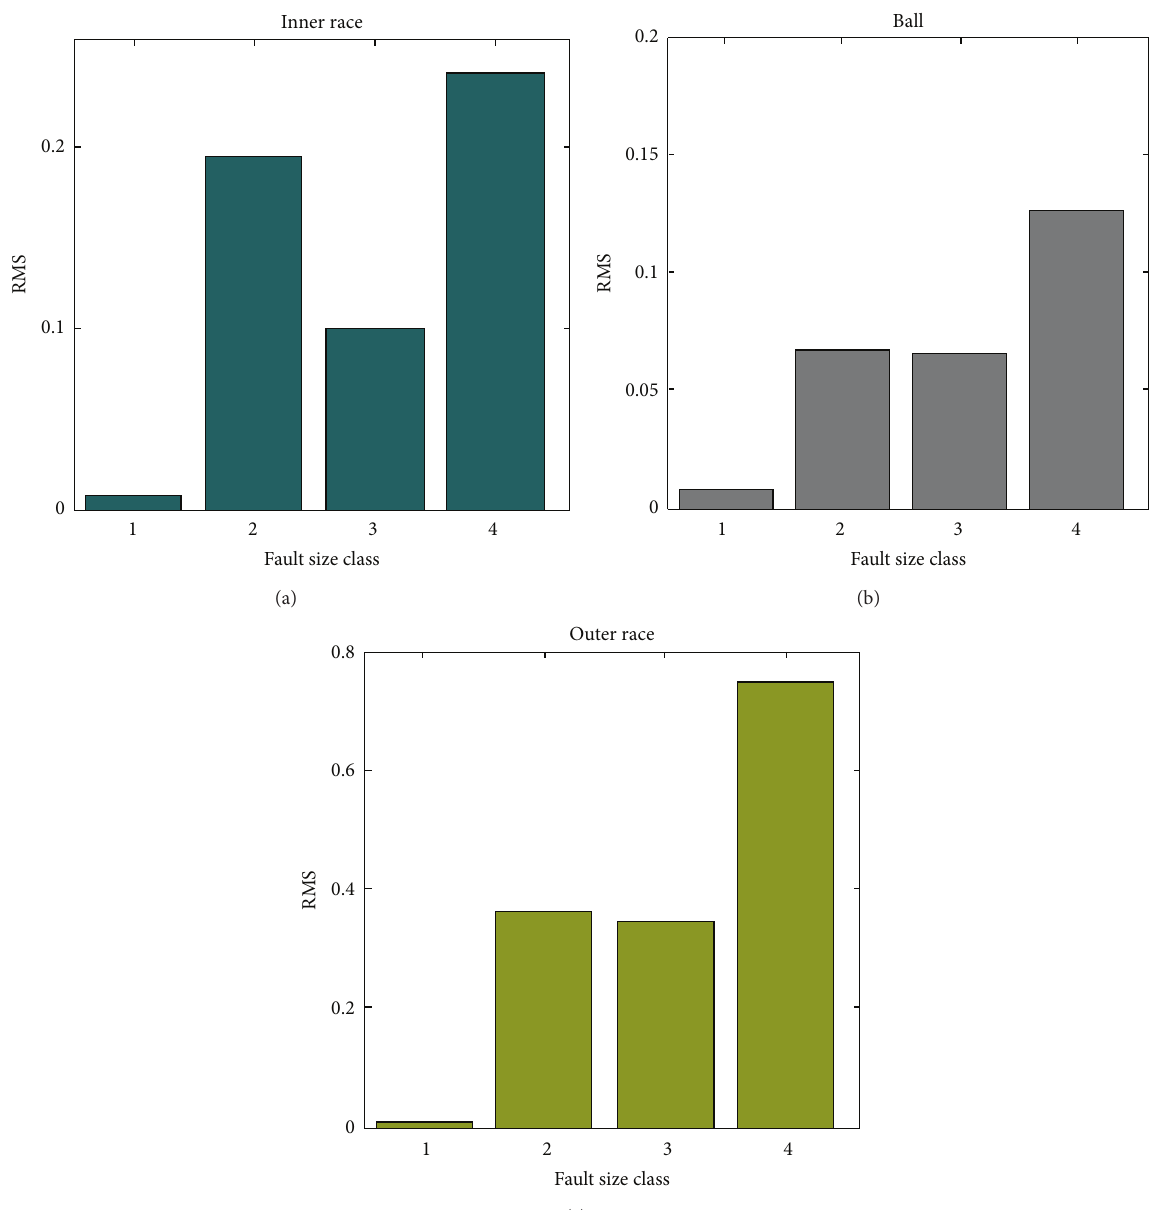
Figure 10: The RMS of three bearing fault